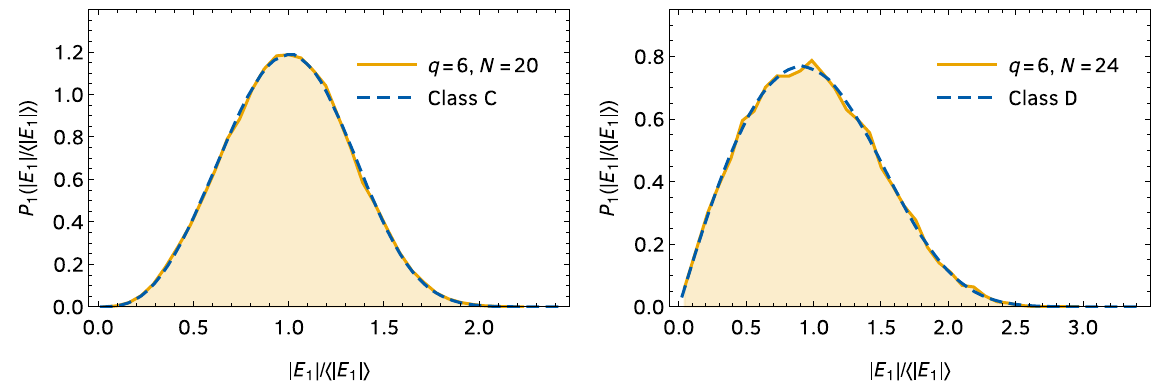
FIG. 10. Distribution of the eigenvalues of H with the smallest absolute value for the q ¼ 6 nHSYK model with N ¼ 20 and N ¼ 24 (filled histogram), compared with the random matrix theory predictions for the non-Hermitian classes C and D, respectively (dashed curves). The RMT predictions are obtained by exactly diagonalizing 10 7 random matrices of dimension 100 structured according to the fourth column of Table I. The nHSYK results (solid curves) are obtained from an ensemble of approximately 4 . 5 × 10 4 and 3 × 10 4 realizations for N ¼ 20 and N ¼ 24 , respectively, resulting in much larger finite-size effects. The comparison is parameter-free and does not involve any fitting.